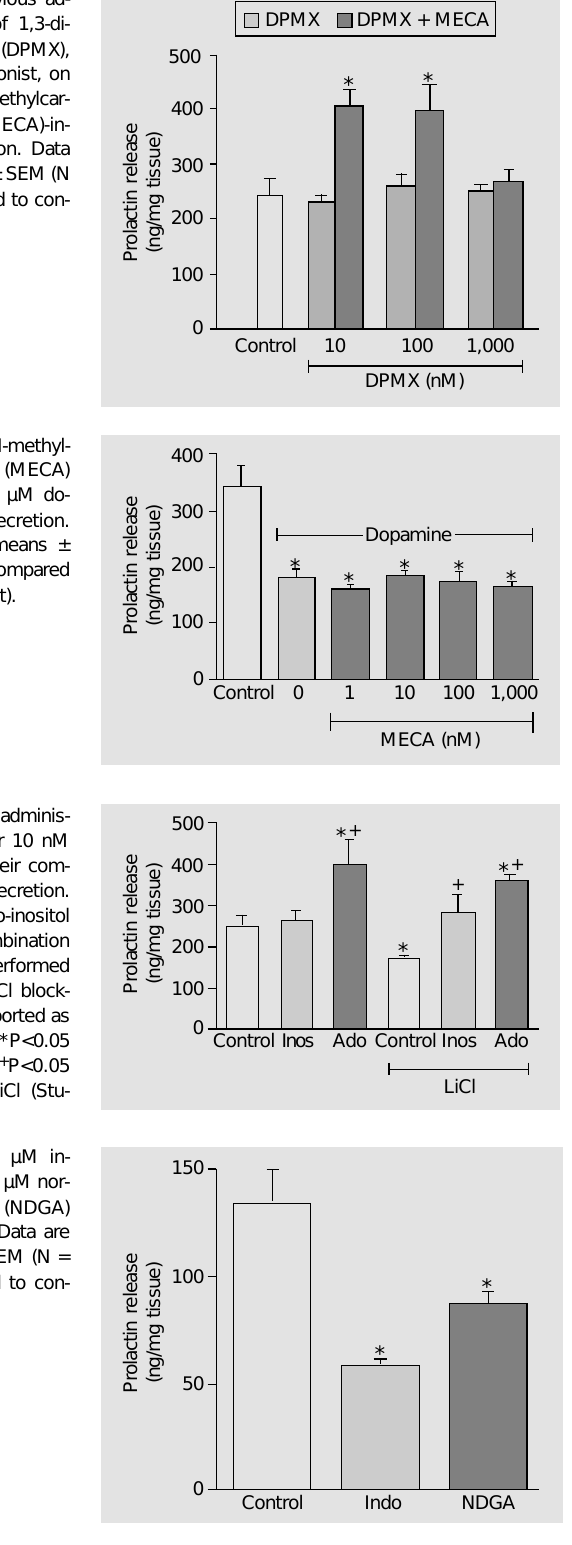
Figure 2. Effect of previous ad- ministration (30 min) of 1,3-di- propyl-7-methylxanthine (DPMX), an A 2 adenosine antagonist, on basal or 10 nM 5-N-methylcar-